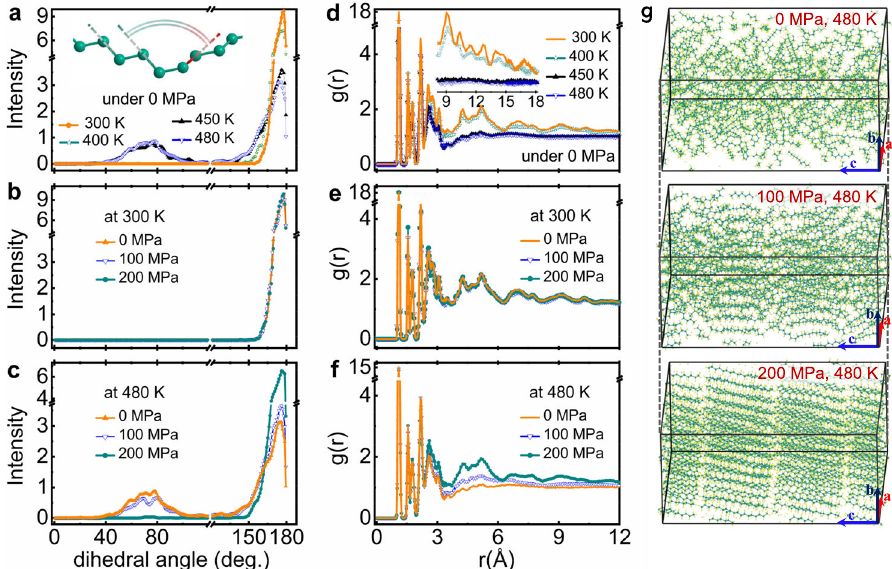
Fig. 4 The theoretical calculation of structural information under different pressures for C 18 H 38 . The distribution intensity of dihedral angle (sketched in inset of a ) between the next-neighbor C – C bonds at different temperatures; the distribution intensity of dihedral angle under different pressures at T S = 480 K ( c ); d the radial distribution function g( r ) at different temperatures; the g( r ) curves under different pressures at T S 300 K ( b ), and T S MD = 480 K ( f ); g the calculated structures under 0, 100 and 200 MPa at T S ( e ), and T S MD